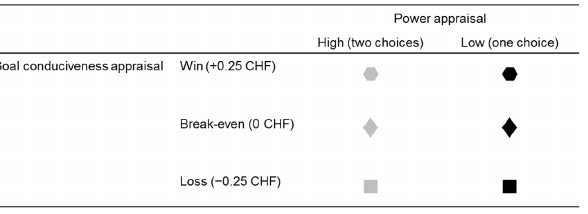
Fig 3. Example of feedback stimuli for the operationalization of goal conduciveness and power appraisals. The associations of the geometric shapes with the levels of goal conduciveness, and the meaning of the gray or black color of these shapes with the levels of power appraisals were counterbalanced across participants.